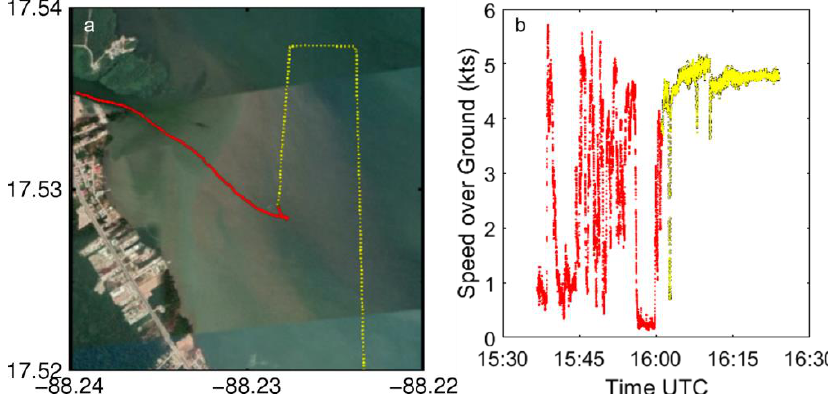
Figure 5. ( a ) Modes of operation of the CW4: remotely operated (red line) in the Belize River due the shallow nature of the river mouth and on a pre-planned mission when water depth increased (yellow dotted line). ( b ) The corresponding speeds for the two operating modes shown in panel ( a ).